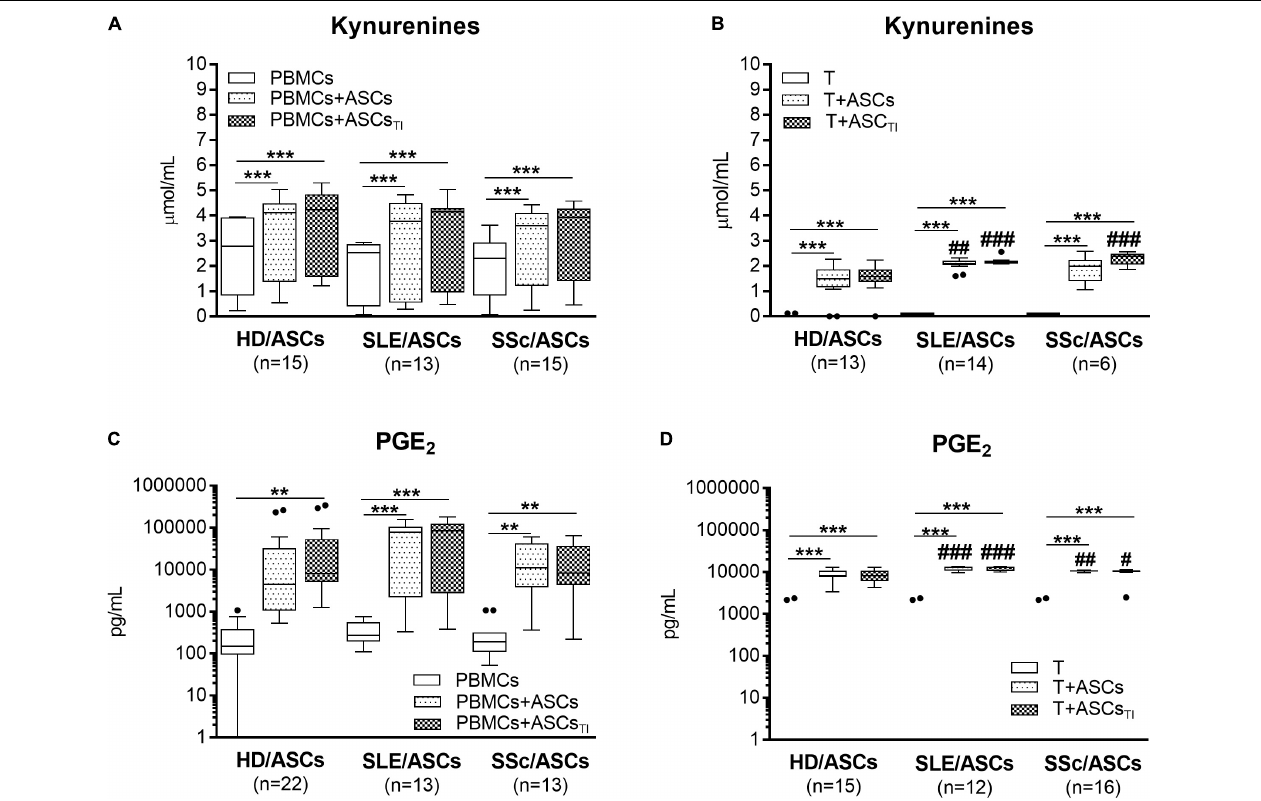
FIGURE 5 | Upregulation of kynurenines and PGE 2 synthesis in the co-cultures of ASCs with activated target cells. (A,C) PBMCs obtained from 13 healthy blood volunteers were stimulated with PHA and co-cultured in the same conditions as in Figure 1 with 5 HD/ASCs, 11 (A) or 7 (C) SLE/ASCs, and 10 (A) or 9 (C) SSc/ASCs. B,D: CD4 + T cells were purified from 12 healthy blood volunteers, stimulated with anti-CD3/anti-CD28 antibodies and co-cultured in the same conditions as in Figure 2 with 5 HD/ASCs, 8 (B) or 6 (D) SLE/ASCs, and 6 (B) or 8 (D) SSc/ASCs. The concentrations of kynurenines and PGE 2 were measured in culture supernatants as described in the section “Materials and Methods.” Data are the results of the indicated number of experiments ( n ) and are shown as the Tukey’s boxes. * P < 0.05, ** P < 0.01, *** P < 0.001 for comparisons of cell co-cultures versus separate control cultures; # P < 0.05, ## P < 0.01, ### P < 0.001 for the groups of patients versus HD comparison. Other explanations as in Figures 1 , 2